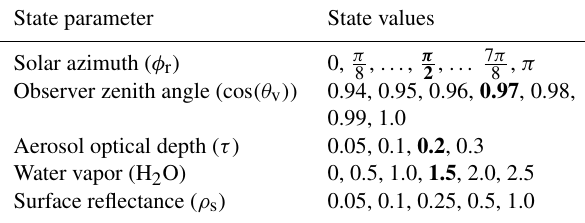
Table 1. State parameters values used in libRadtran model runs to generate ρ obs spectra to train and validate the neural RTM. State vectors containing the median value of each auxiliary parameter (indicated by bold text) are held out for testing, while the remaining state vectors are used for training the channelwise